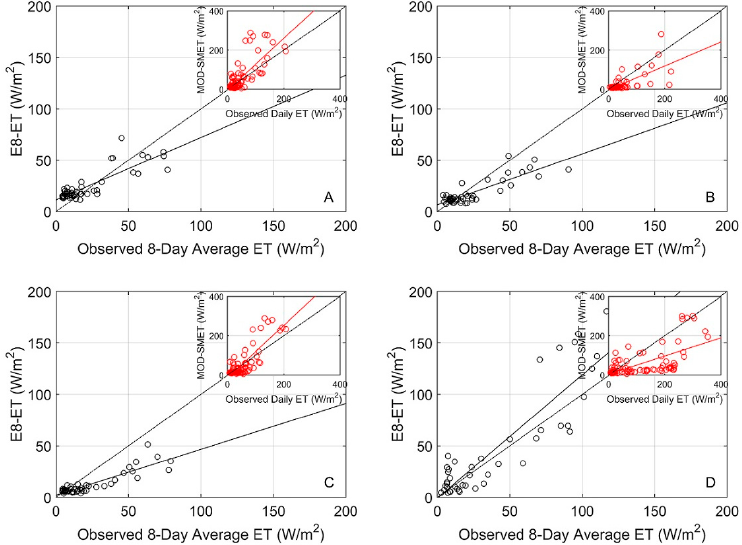
Figure 7. Comparison between daily average modeled ET and observed daily ET (inset) and eight-day average empirical ET to observed eight-day average ET for sites: Whs ( A ); SRM ( B ); Wkg ( C ); and CMW ( D ).